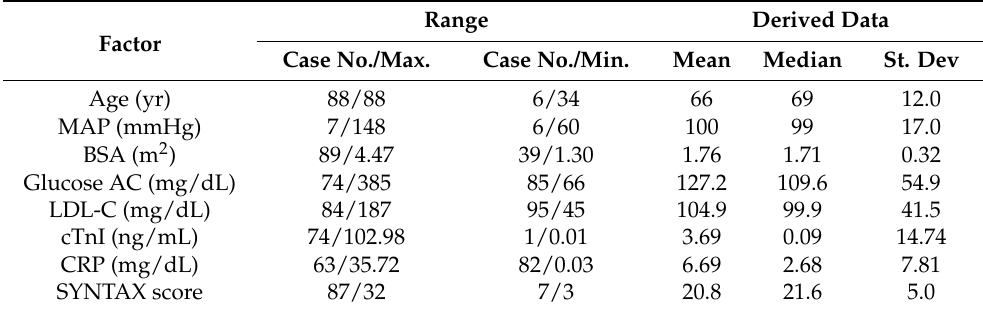
Table 4. Detailed information of the verified group of 105 patients with similar cardiovascular artery diseases was randomly adopted from the same patient group as the original one. Range Derived Data Factor Case No./Max. Case